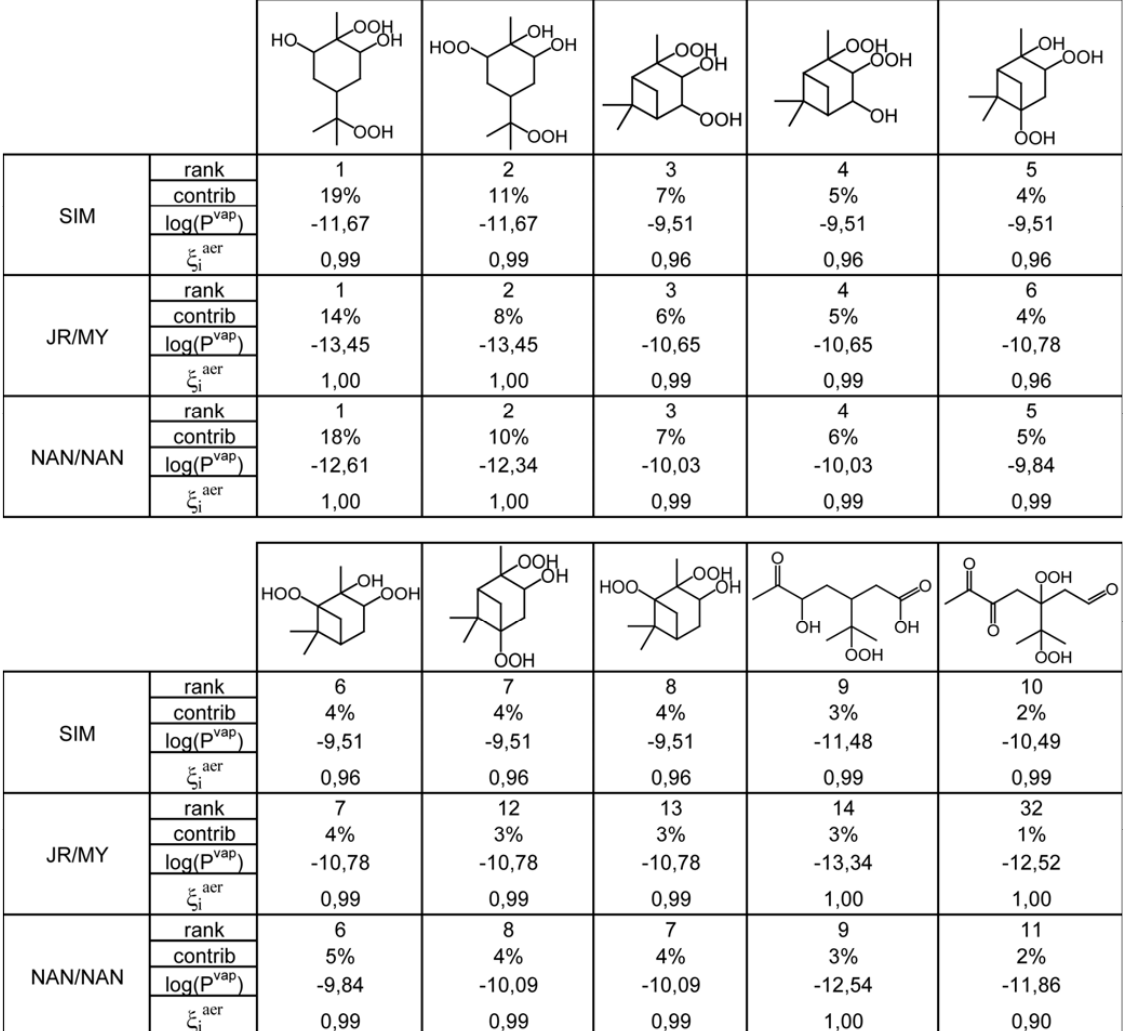
Table 4. Top 10 species in SOA simulated with SIM in the low NO x experiment, with their rank and contribution to the total simulated SOA mass. ξ aer is computed at the end of the experiment.